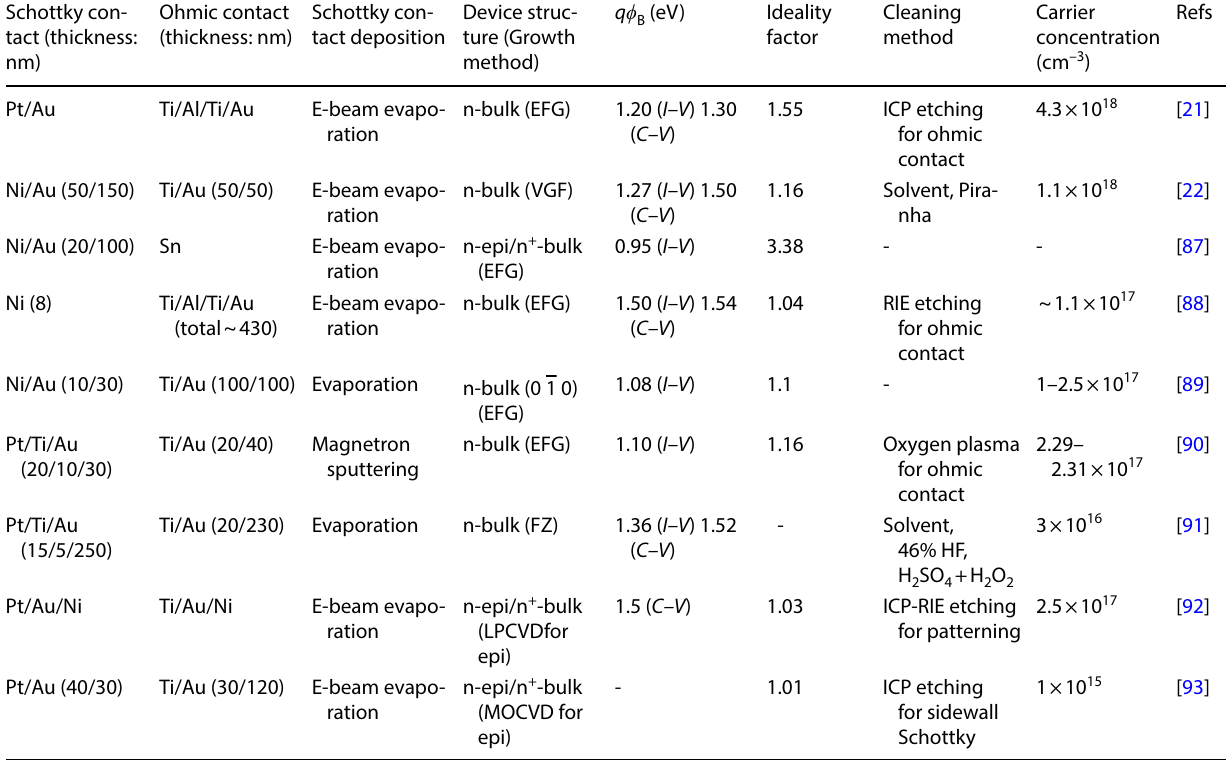
O reported in the literature 2 3